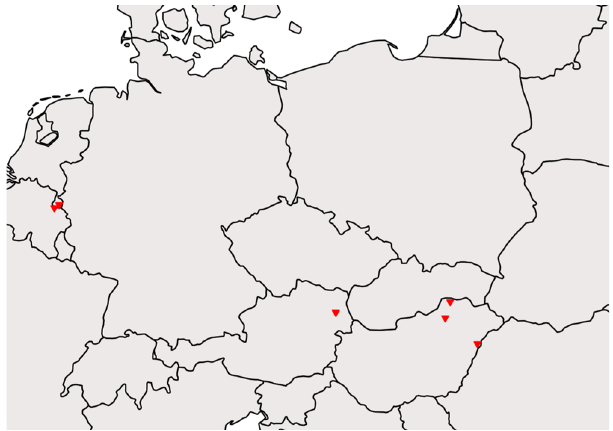
Figure 2. Field sites where ants for this project have been collected. Field sites are located in Europe (Austria, Belgium, Hungary, The